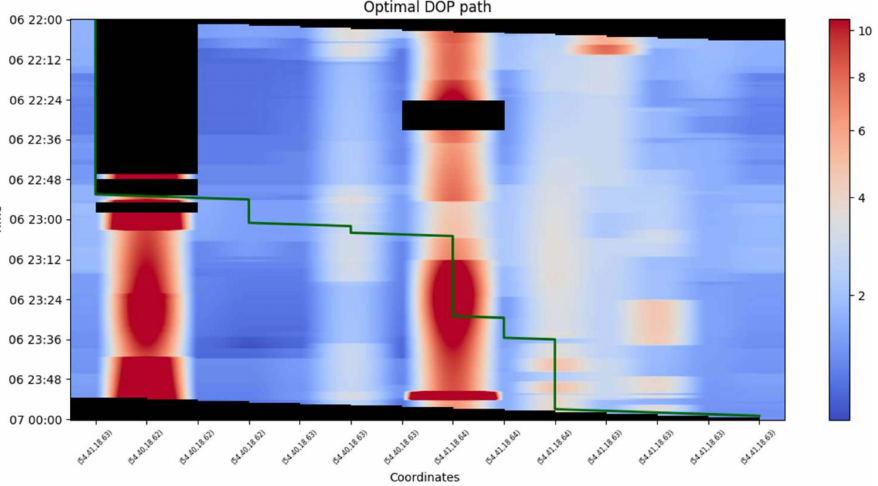
Figure 11. Diagram of the optimal 2D route during the first measurement campaign implementation.